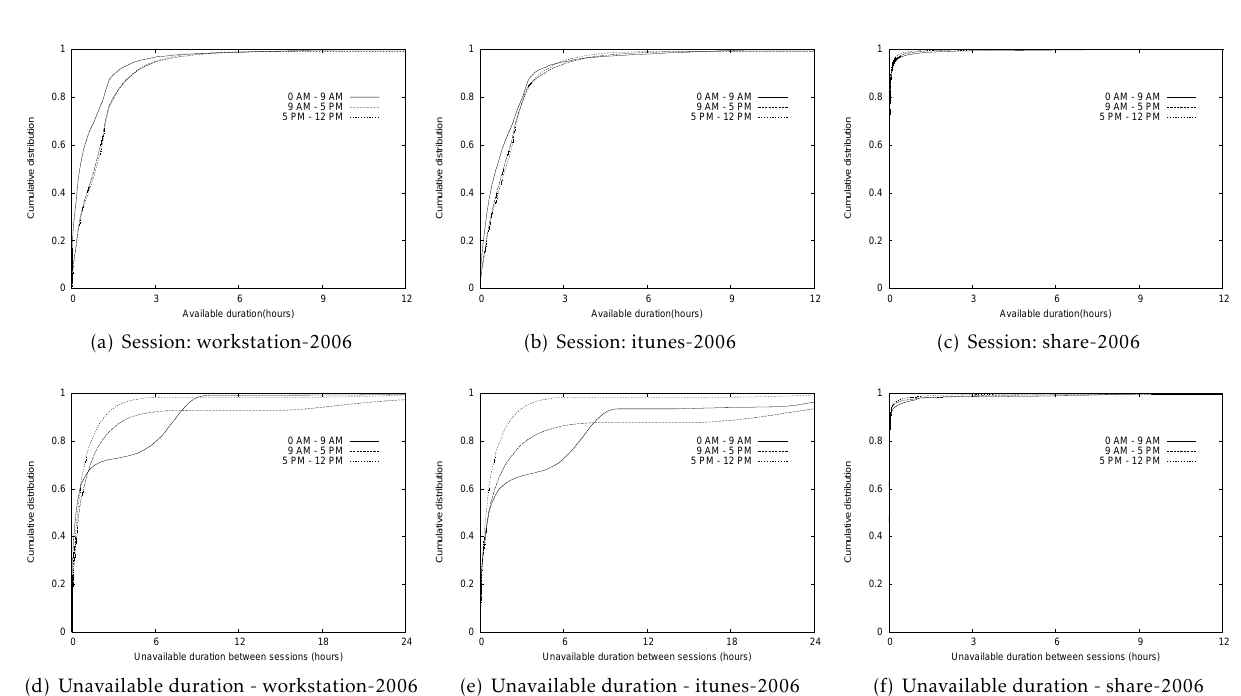
Figure 6. Session durations in different time